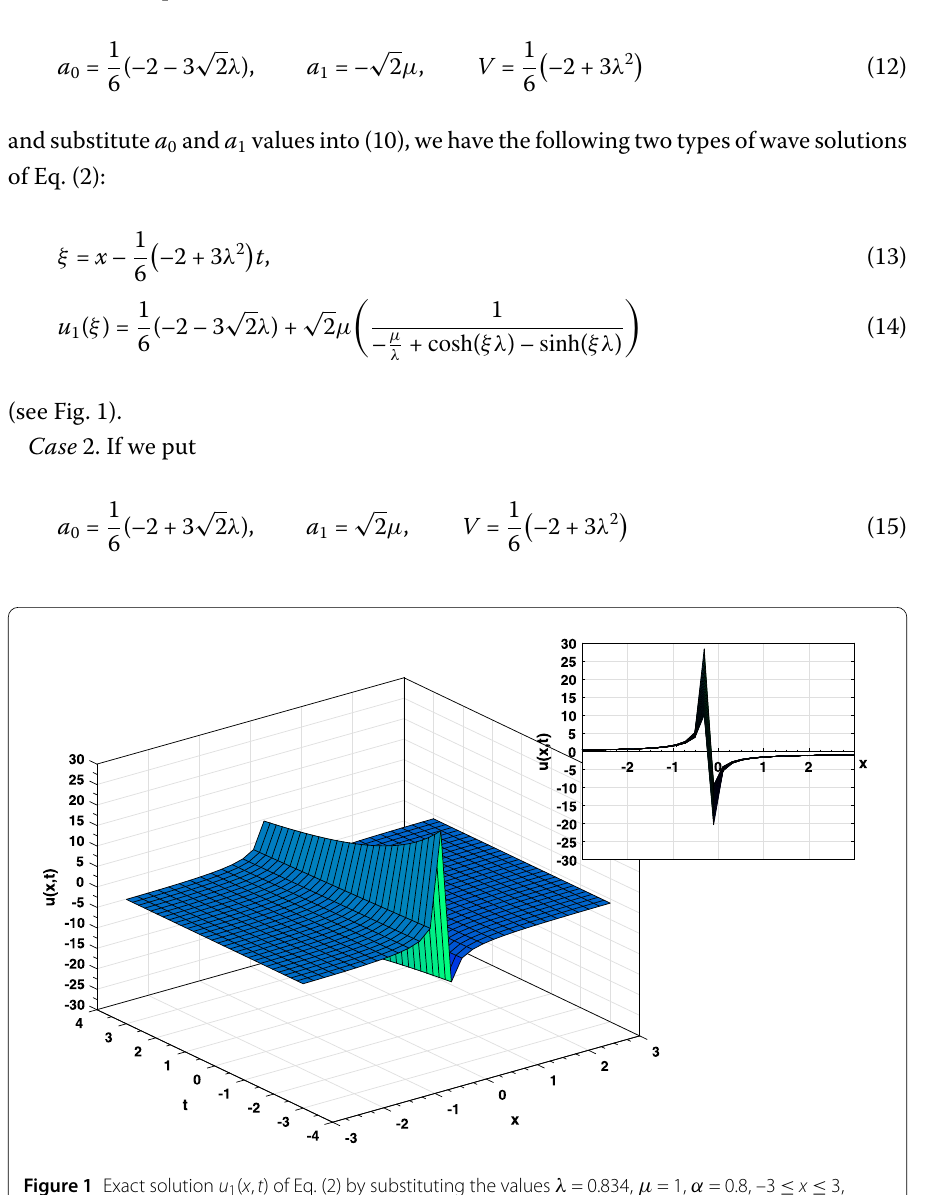
Figure 1 Exact solution u 1 ( x , t ) of Eq. (2) by substituting the values λ = 0.834, μ = 1, α = 0.8, –3 ≤ x ≤ 3, –4 ≤ t ≤ 4, γ = 1 for the 2D